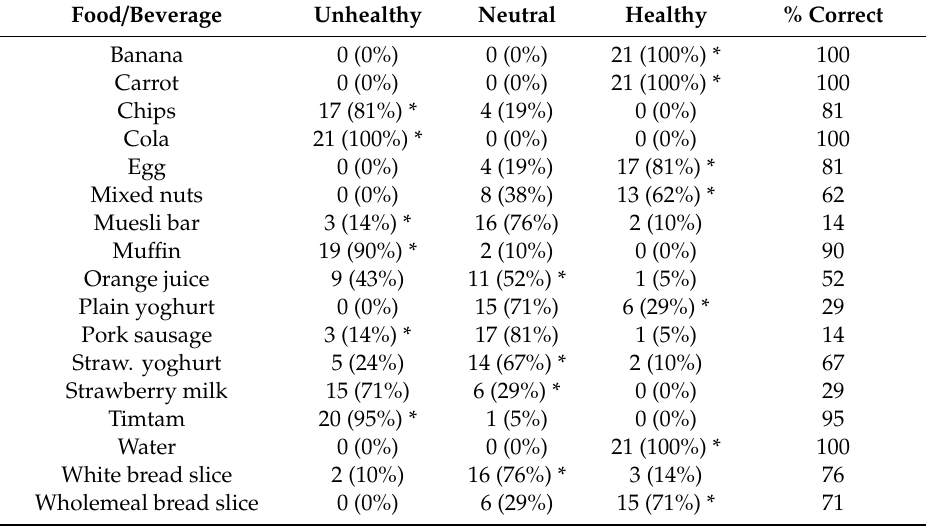
Table 4. Results of sorting food items and beverages ( n = 21).